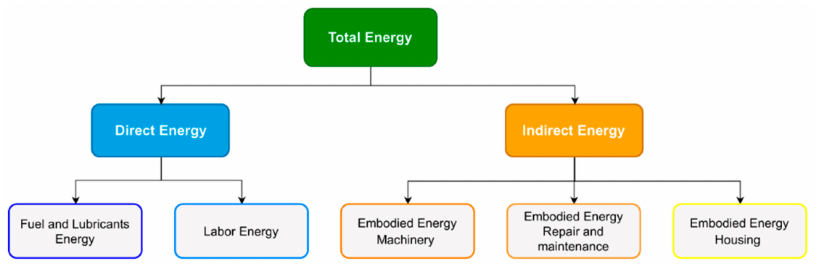
Figure 1. Energy costs of agricultural